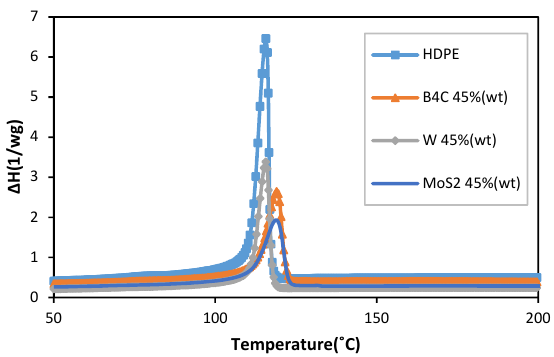
Fig. 15. Cooling DSC curves for composite samples containing 45%(wt) fillers at a temperature range of 50 to 200 o C.